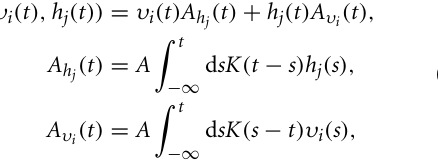
weight update follows a STDP rule modulated by a zero mean signal g ( t ) . This signal switches the behavior of the synapse from Long-Term Potentiation (LTP) to Long-Term Depression (LTD), and partitions the training into two phases analogous to those of the original CD rule. The spikes cause microscopic weight modifications, which on average behave as the macroscopic CD weight update. For this reason, the learning rule is referred to as event-driven